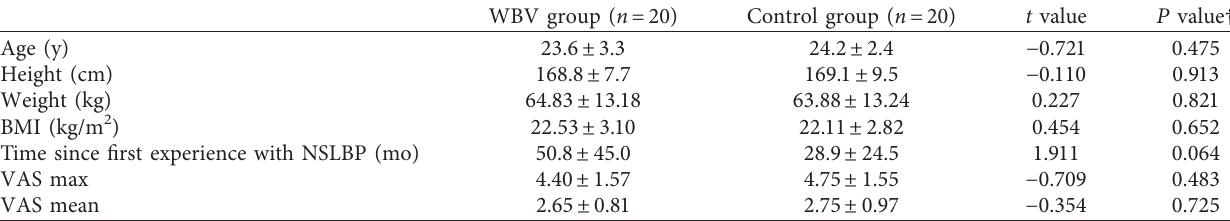
Table 2: Demographic and clinical characteristics of participants.